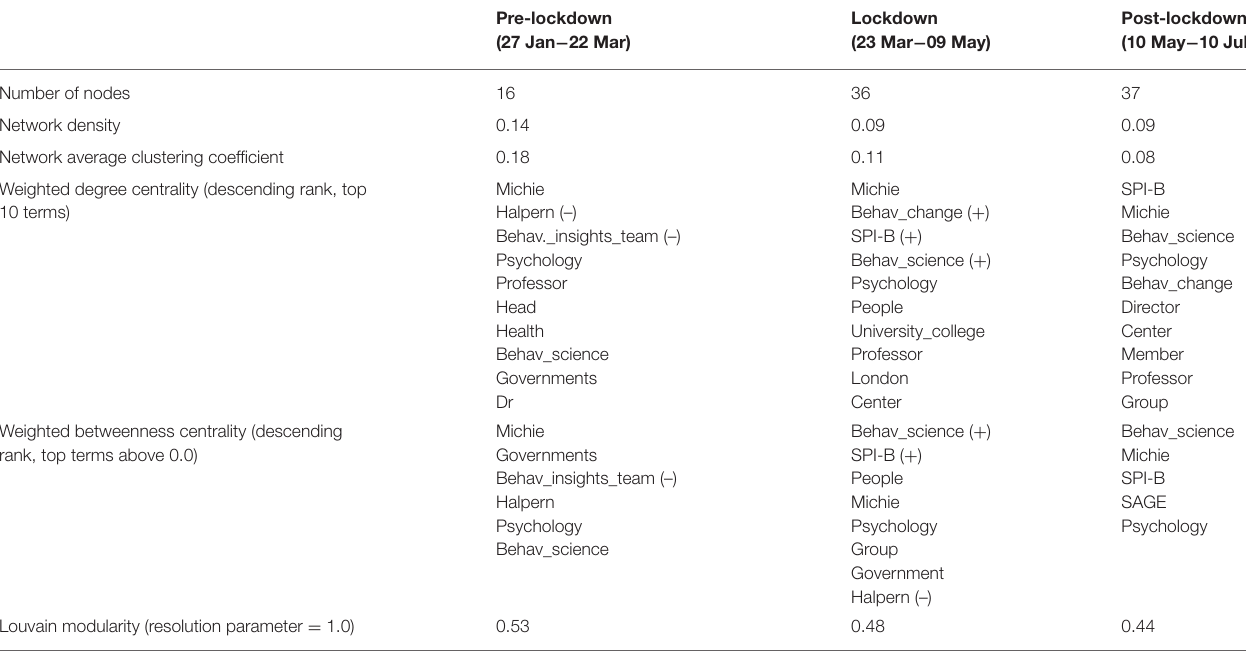
TABLE 1 | Structural network statistics on the opinion-context co-occurrence networks pre- during- and